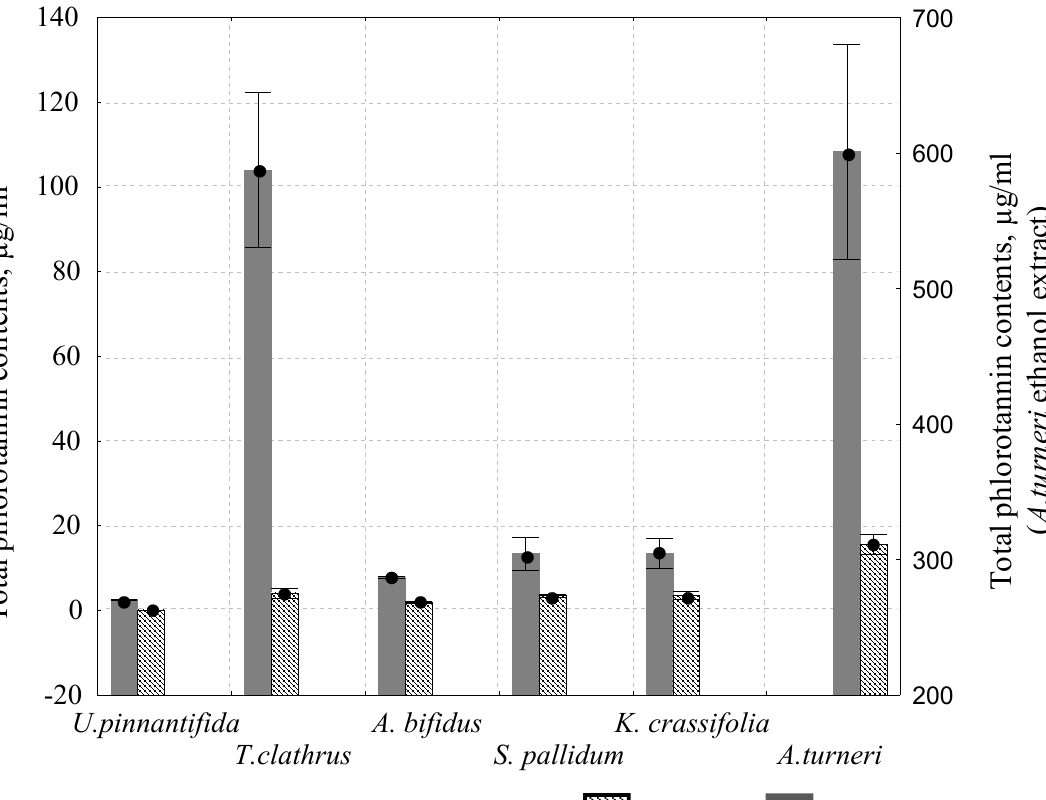
Figure2. Totalphlorotannincontentinbrownalgaewater( Figure 2. Total phlorotannin content in brown algae water ( ) and ethanol ( ) extracts. Right Figure 2. Total phlorotannin content in brown algae water ( ) and ethanol ( ) extracts. Right Figure 2. Total phlorotannin content in brown algae water ( ) and ethanol ( ) extracts. Right axis—date for A. turneri. axis—date for A. axis—date for A. turneri.